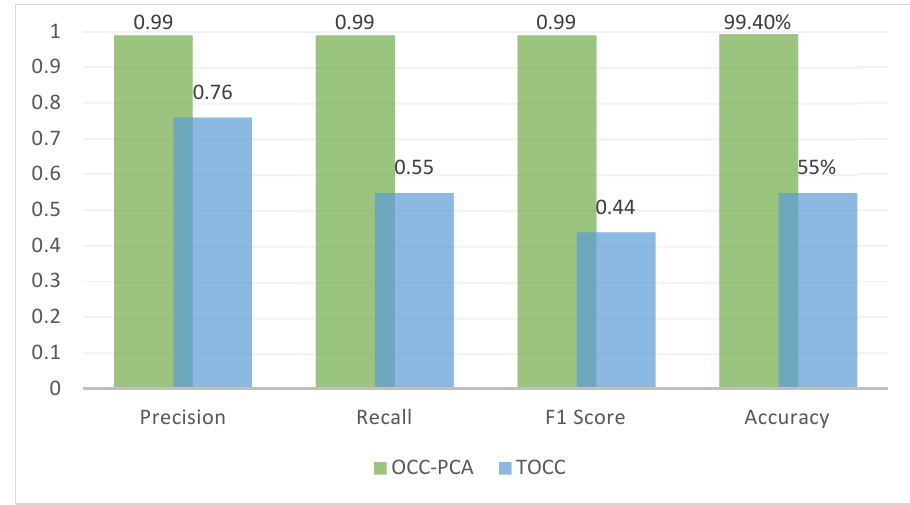
Figure 6. Comparison between TOCC and OCC ‐ PCA Results.